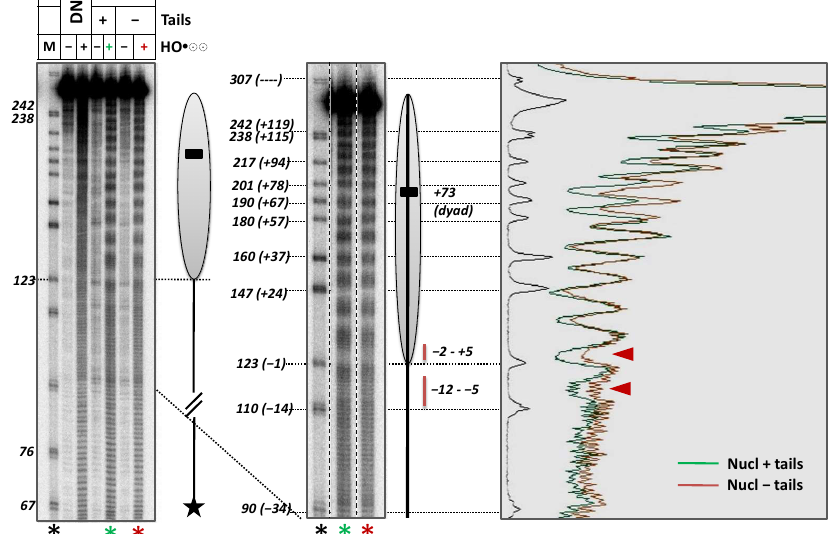
Figure 5. Histone tails strongly contribute to protection of nucleosomal and linker DNA from hy- droxyl radicals. The 5′-end of the non-template DNA strand was radioactively labeled. Nucleosomes with or without histone tails were incubated in the presence of hydroxyl radicals. End-labeled DNA was analyzed by denaturing PAGE (on the left ). M—pBR322 MspI digest. Lanes labeled by colored asterisks (black for markers, green for nucleosomes with histone tails and red for nucleosomes with- out histone tails) are also shown at a higher magnification in the middle ; corresponding scans are shown on the right . Nucleosome position is shown by the grey oval. Red lines and arrows indicate DNA regions protected from hydroxyl radicals by the histone